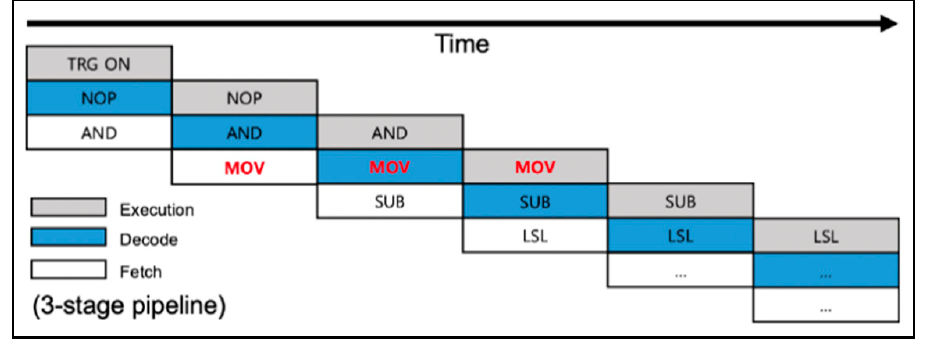
Figure 4. Three-stage pipeline applied to the Cortex-M0.